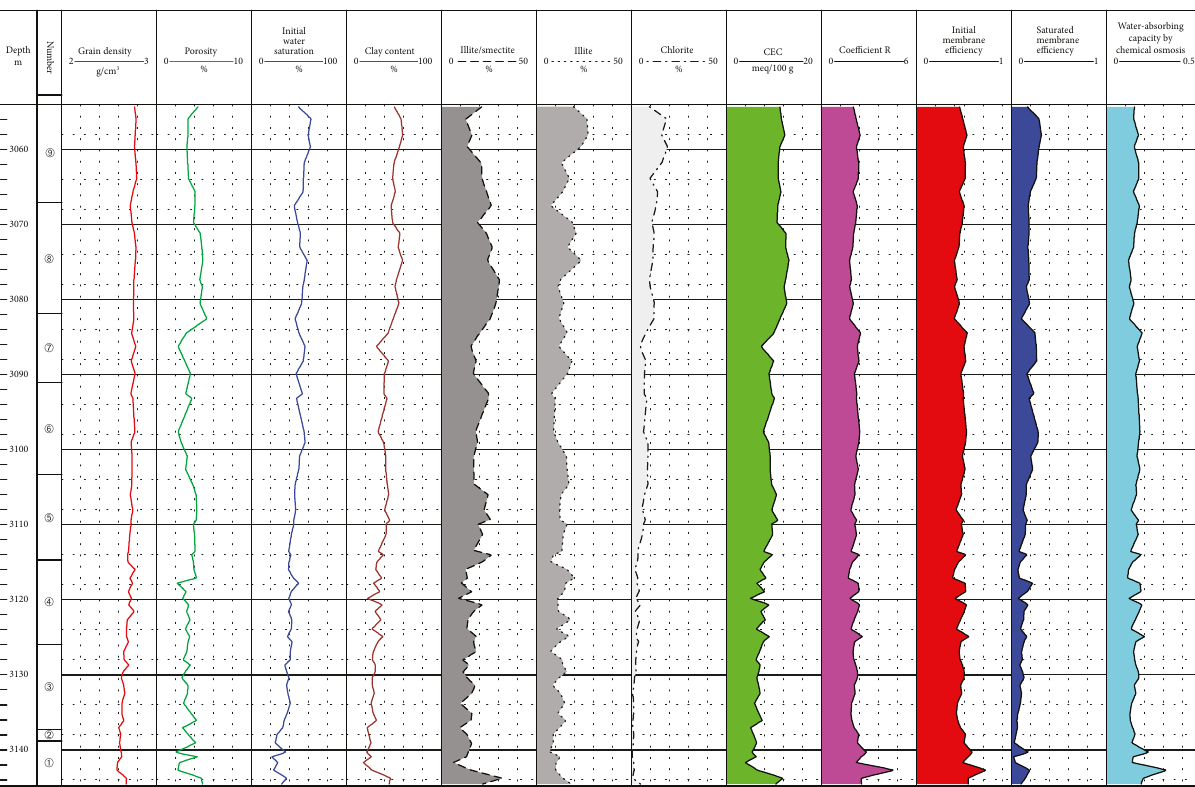
Figure 9: Vertical variation within the water-absorbing capacity by chemical osmosis of reservoir interval